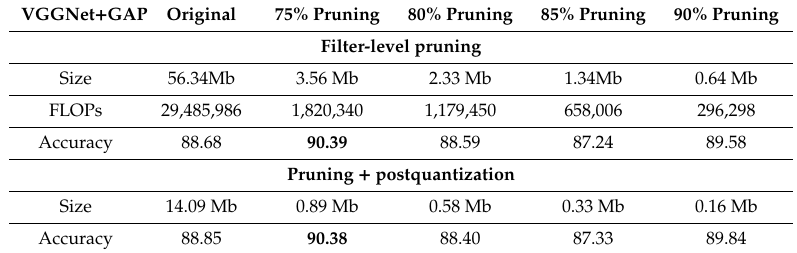
Table 9. Comparison in terms of size and FLOPs of filter-level pruning on VGGNet + GAP with the plant seedlings dataset.